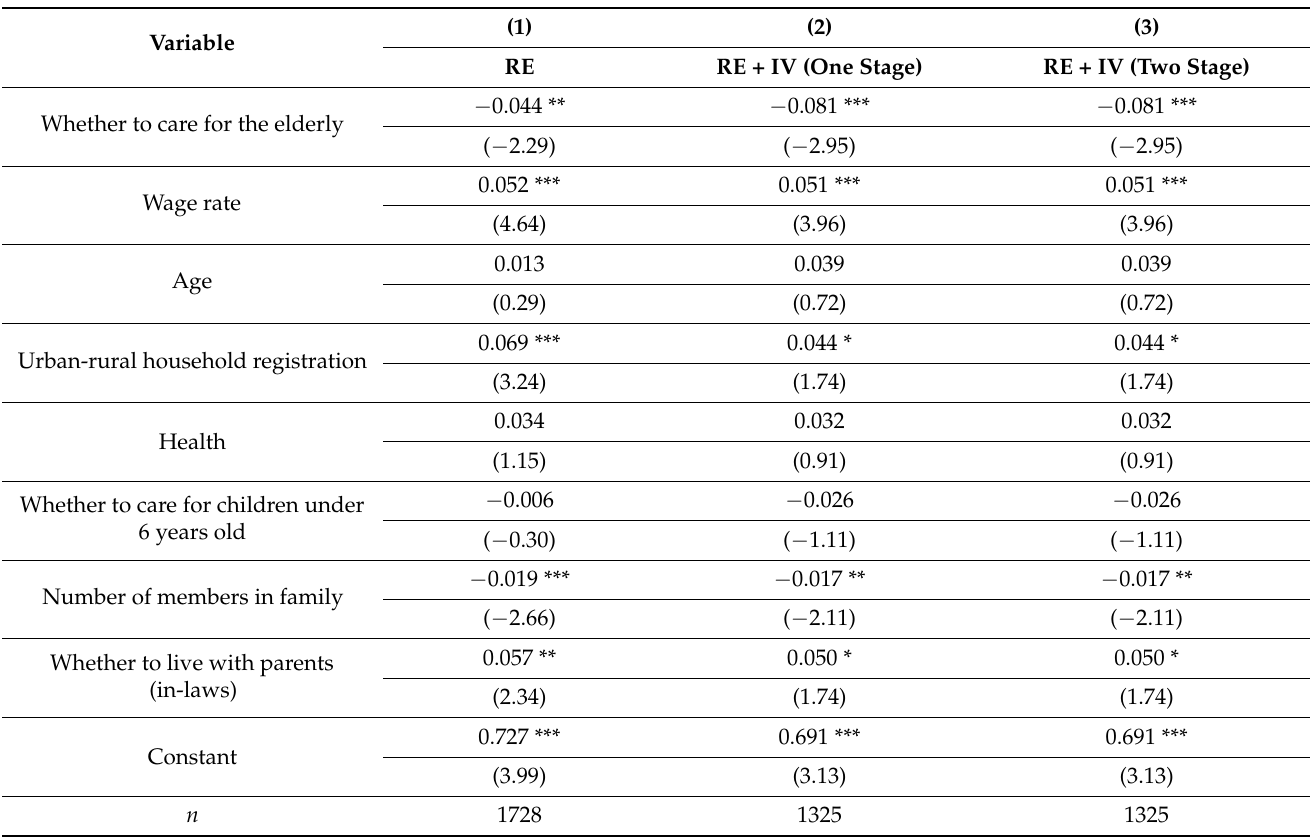
Table 4. Estimation results of